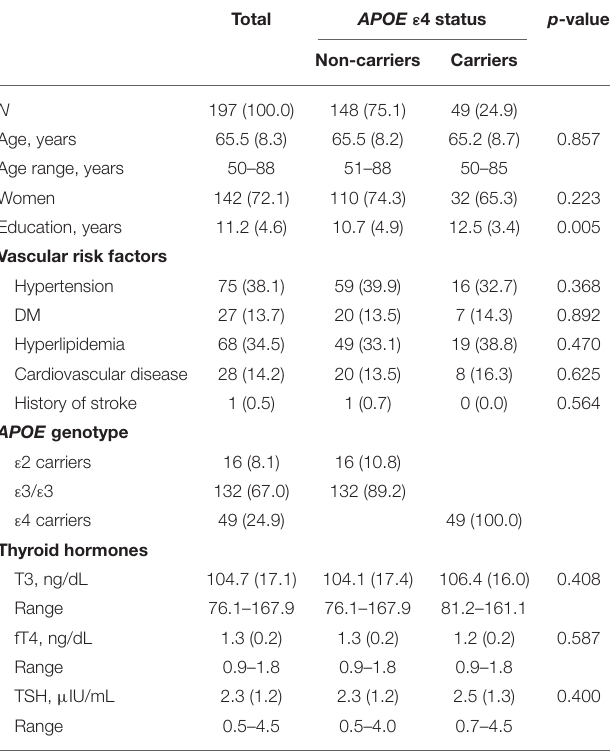
TABLE 2 | Demographic and clinical characteristics of the study